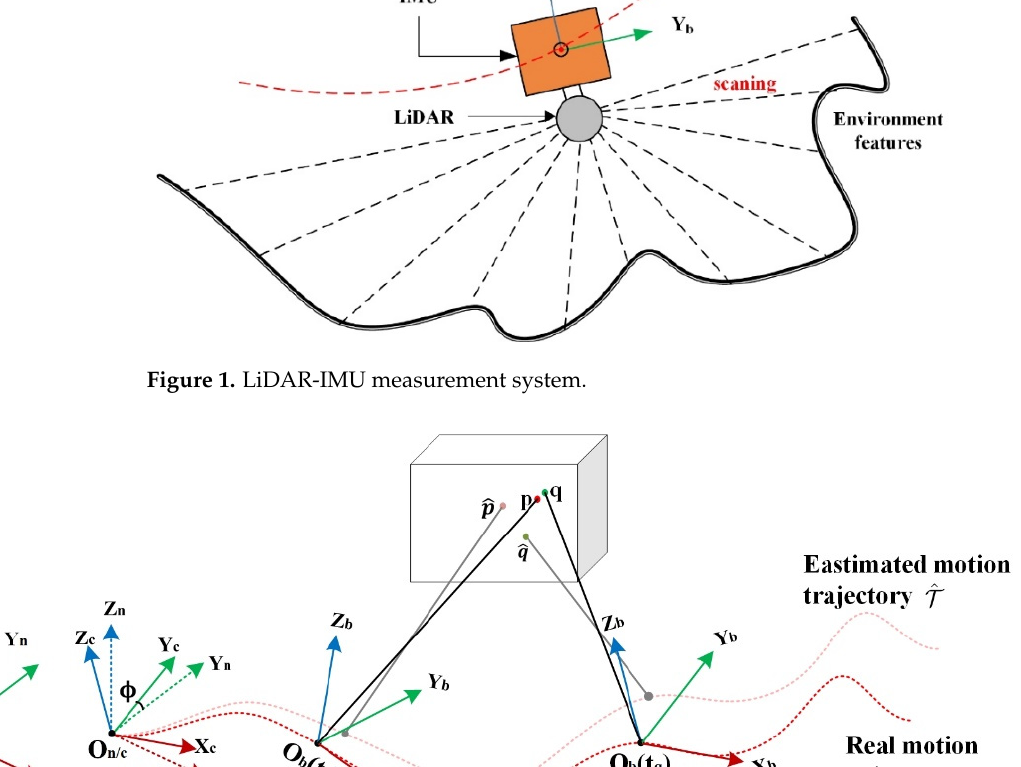
Figure 1. LiDAR-IMU measurement system.